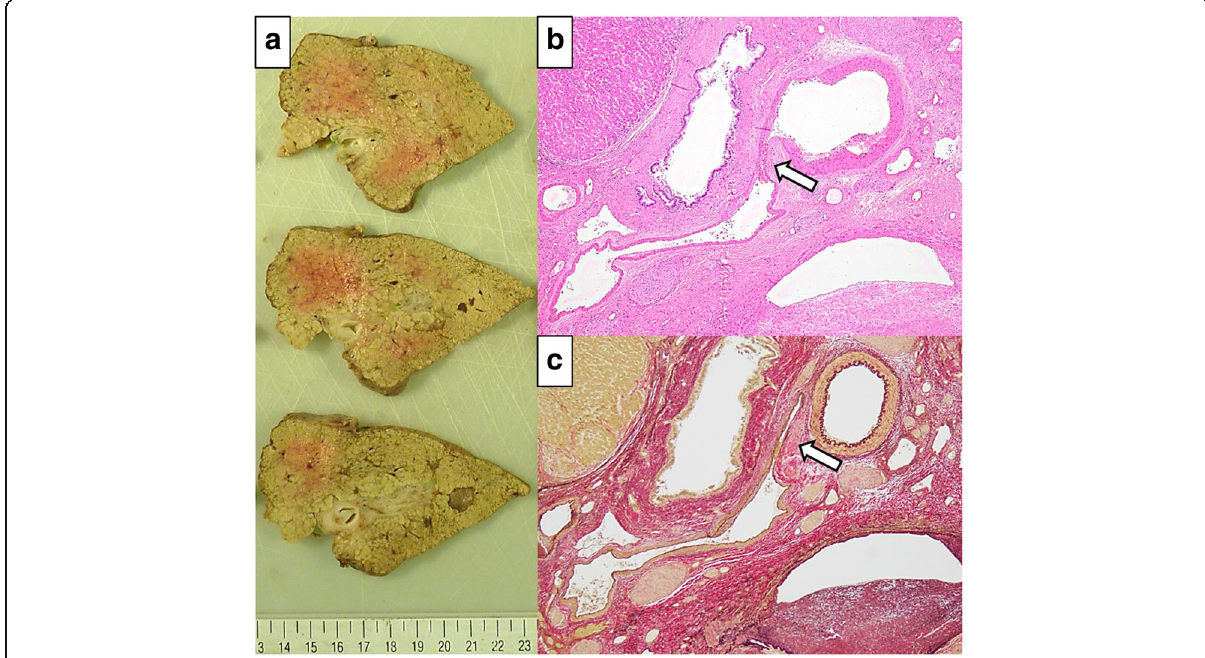
Fig. 6 Macroscopic and microscopic findings. a Arterioportal fistula could not be identified macroscopically. b Many dilatated vessels can be observed in Glisson ’ s sheath. Arterioportal fistula (arrow) can also be observed (hematoxylin-eosin stain). c The portal vein and artery are